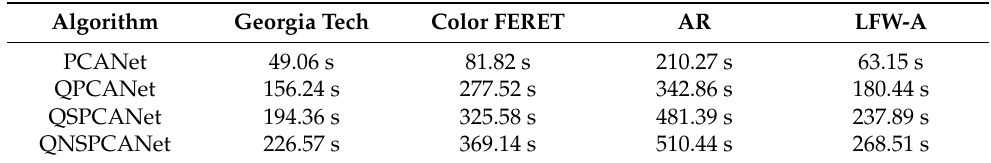
Table 5. Algorithm training time comparison.